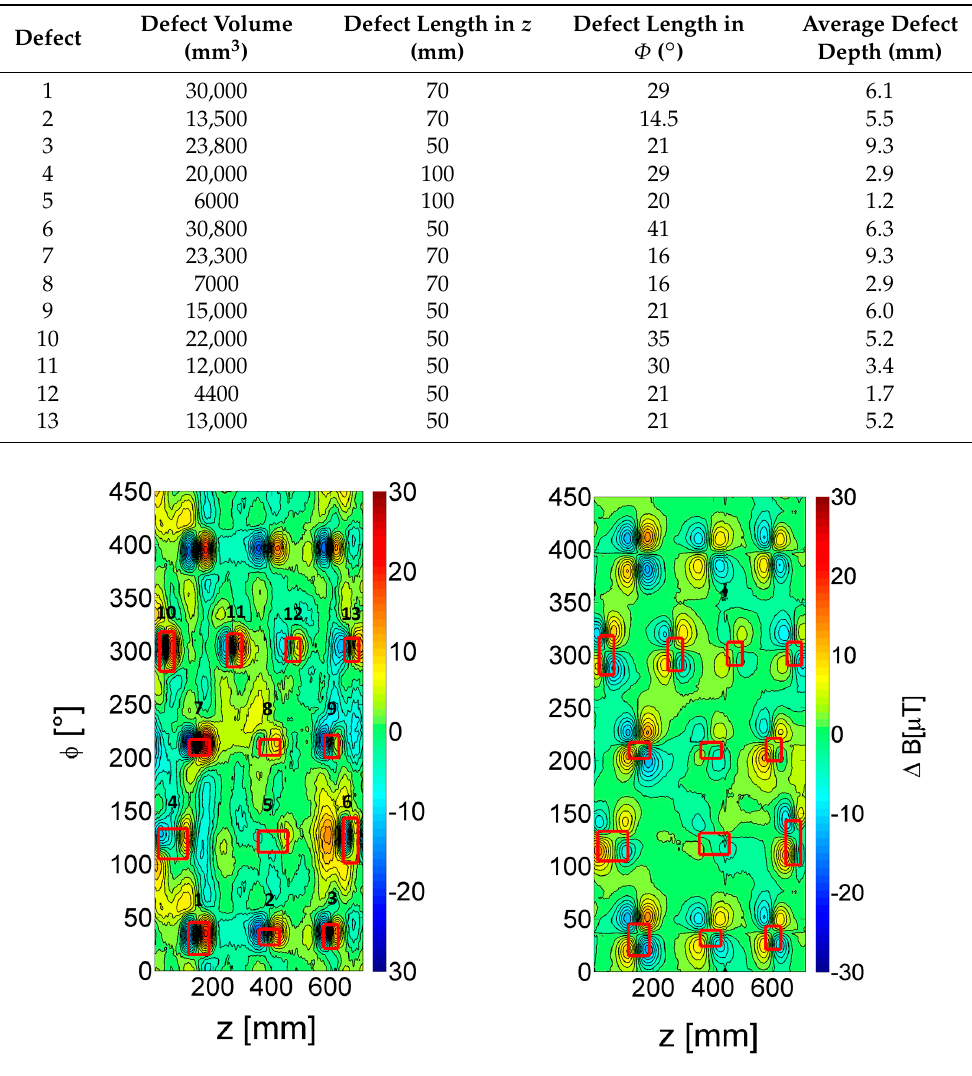
Table 2. Parameters for defects manufactured into surface of pipe.